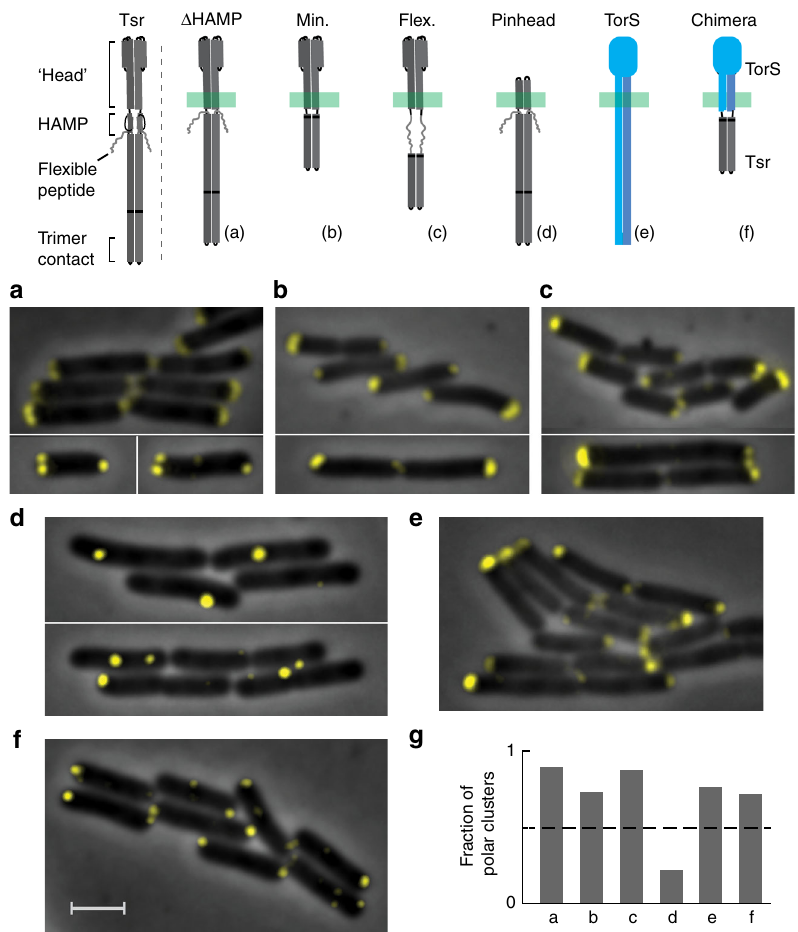
Fig. 5 Positioning of modi fi ed receptors. A schematic description of the receptor variants is provided in the upper panel (see also Supplementary Fig. 5). a – d and f Fluorescence images of Δ ( cheA cheW MCPs ) (UU2806) cells expressing various receptor mutants from an inducible plasmid (pRR48, 100 – 200 µ M IPTG) together with CheA::mYFP and CheW (pAV295, 0.3 µ M NaSal). e Images of TorS-mYFP expressed in MG1655 cells (pES42, induced with 10 µ